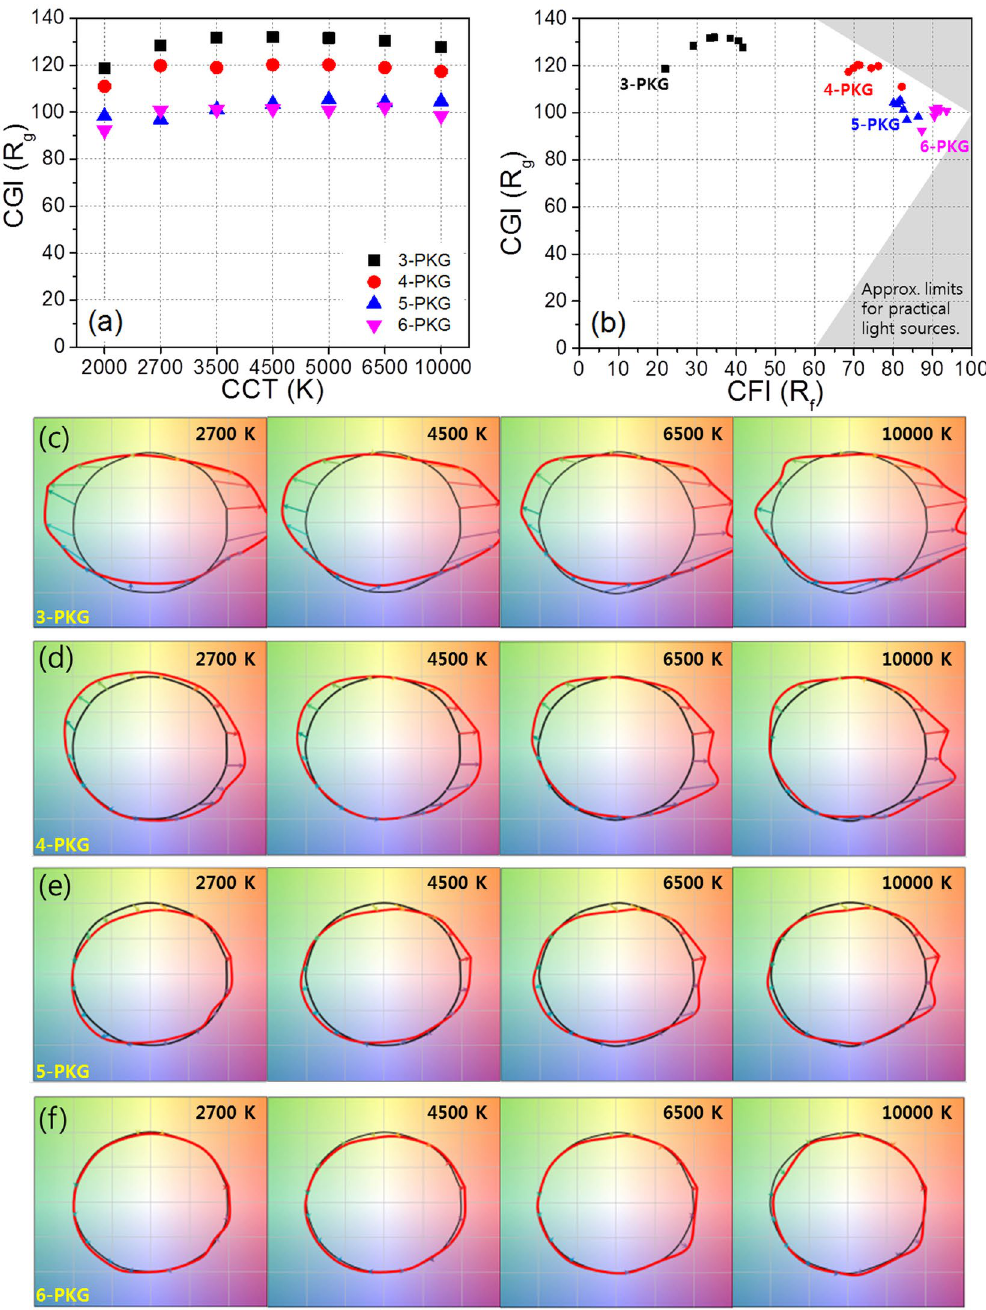
Figure 6. The relationship of ( a ) CGI–CCT, and ( b ) CGI-CFI among the three- to six-package WLEDs. Color icons of the ( c ) three-, ( d ) four-, ( e ) five-, and ( f ) six-package WLEDs at 2700, 4500, 6500, and 10000